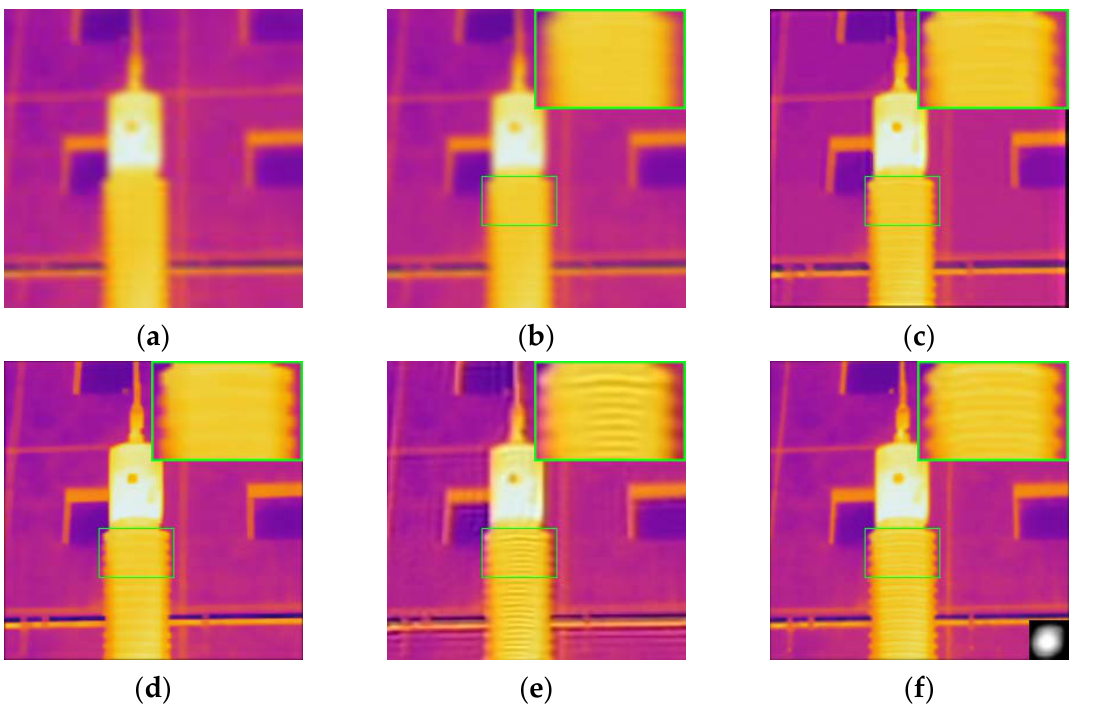
Figure 5. Different methods to reconstruct the real infrared image of No. 9. ( a ) Real infrared image ( b ) Reconstruction results using the method in [30] (AG = 20.705, IE = 6.222) ( c ) Reconstruction results using the method in [19] (AG = 28.421, IE = 6.323) ( d ) Reconstruction results using the method in [11] (AG = 28.452, IE = 6.362) ( e ) Reconstruction results using the method in [21] (AG = 31.559, IE = 6.429) ( f ) Reconstruction results using our method (AG = 30.784, IE = 6.542).